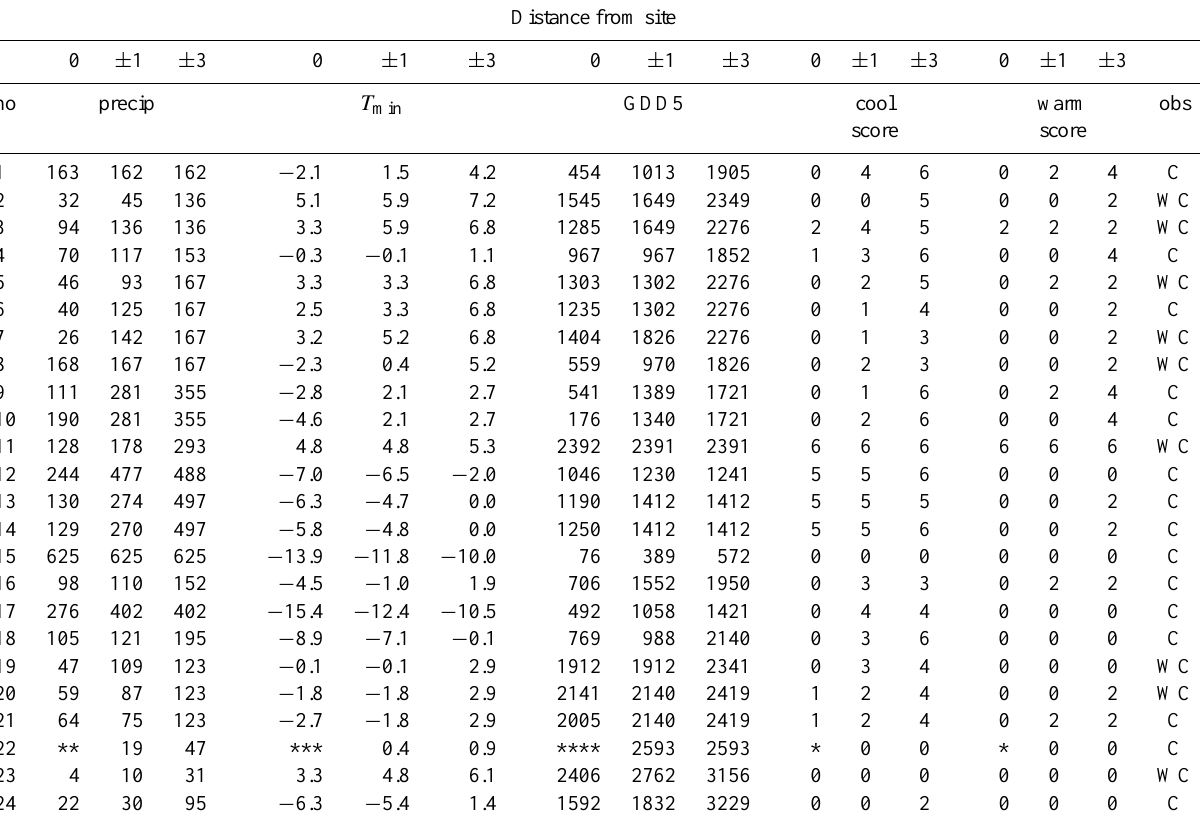
Table 6. Same as Table 5 for the ECHAM5 T31 coupled simulation